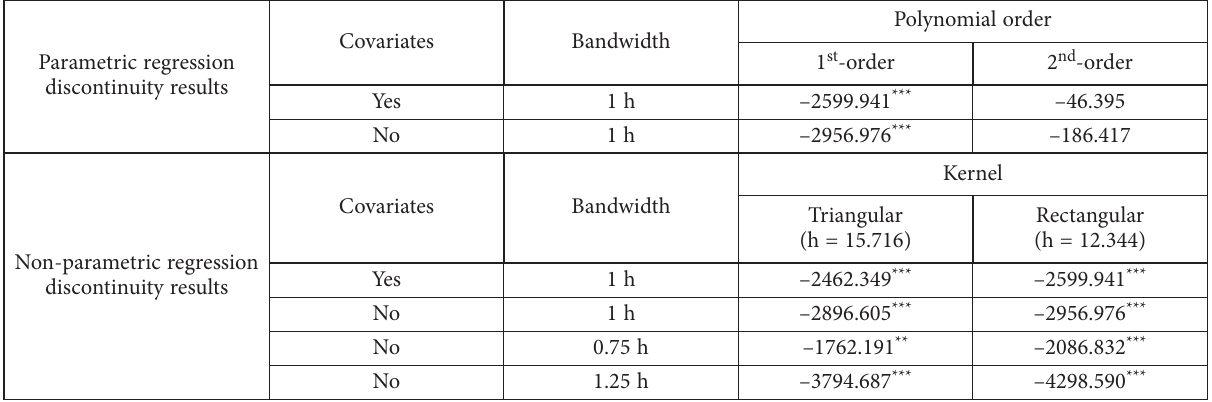
Parametric regression discontinuity results